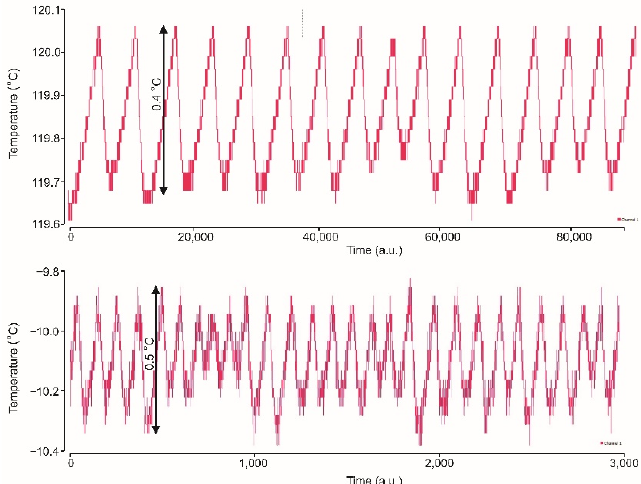
Figure 11. Measured stability of the temperature regulation for heating up to +120 °C ( top ) and cooling down to − 10 °C ( bottom ).